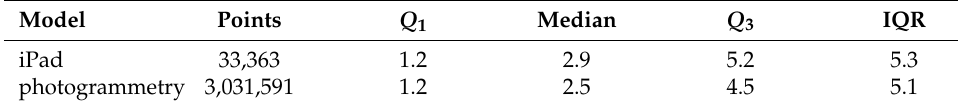
Table 7. Comparison of statistical values for the building facade